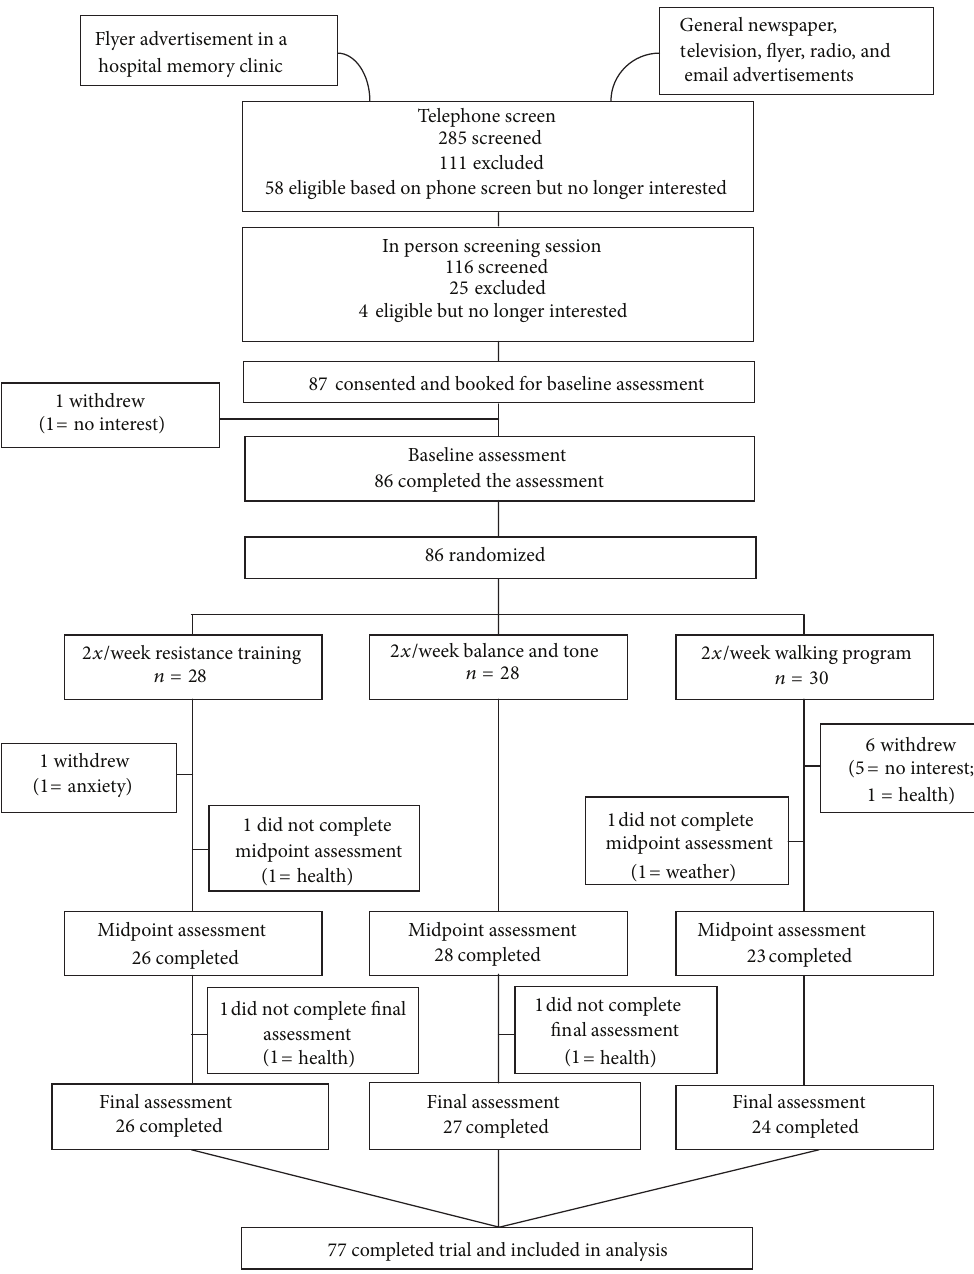
Figure 1: The CONSORT (Consolidated Standards of Reporting Trials)